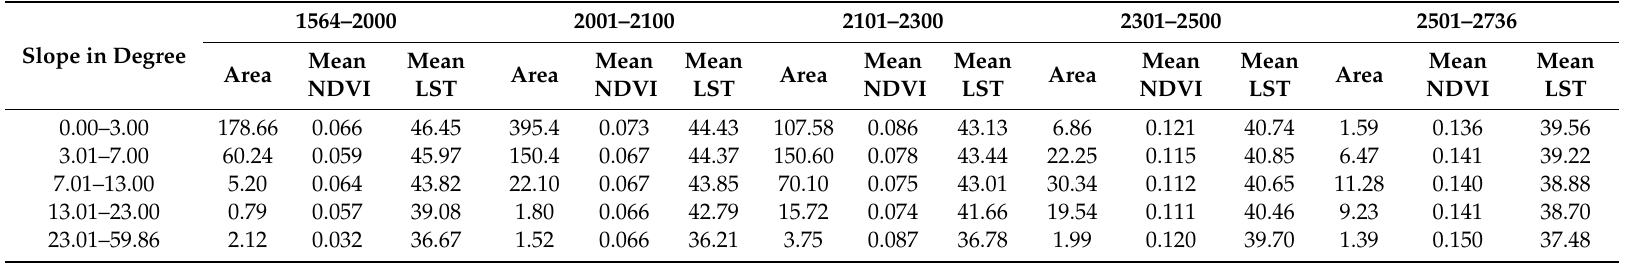
Table 5. Statistical analysis LST and NDVI over the slope classes at the classified elevation